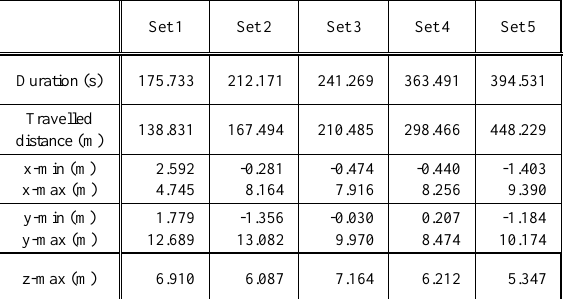
Non-linear Optimization: Figure 10 shows the impact of positioning refinement by Levenberg-Marquardt